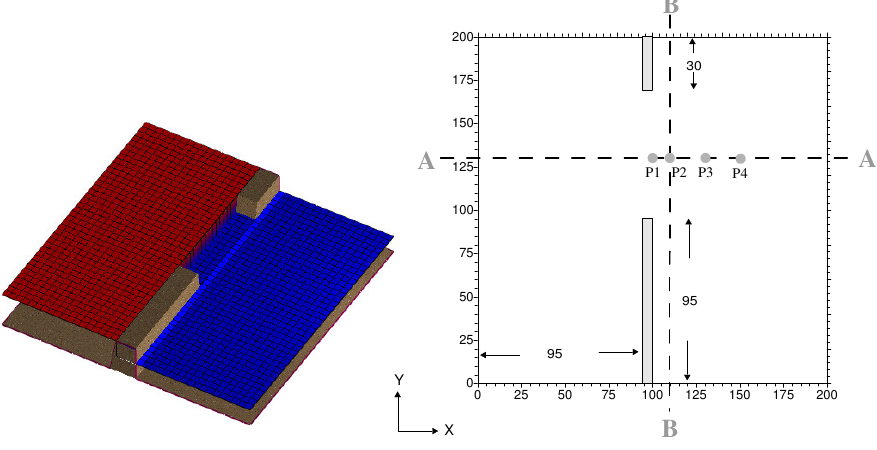
Fig. 2. Plan view (dimension in m) – Geometric Schematization of dam break over flat bed without friction test case. In plan, Sections A-A B-B, Points P1(100,130), P2(110,130),P3(130,130), P4(150,130) are